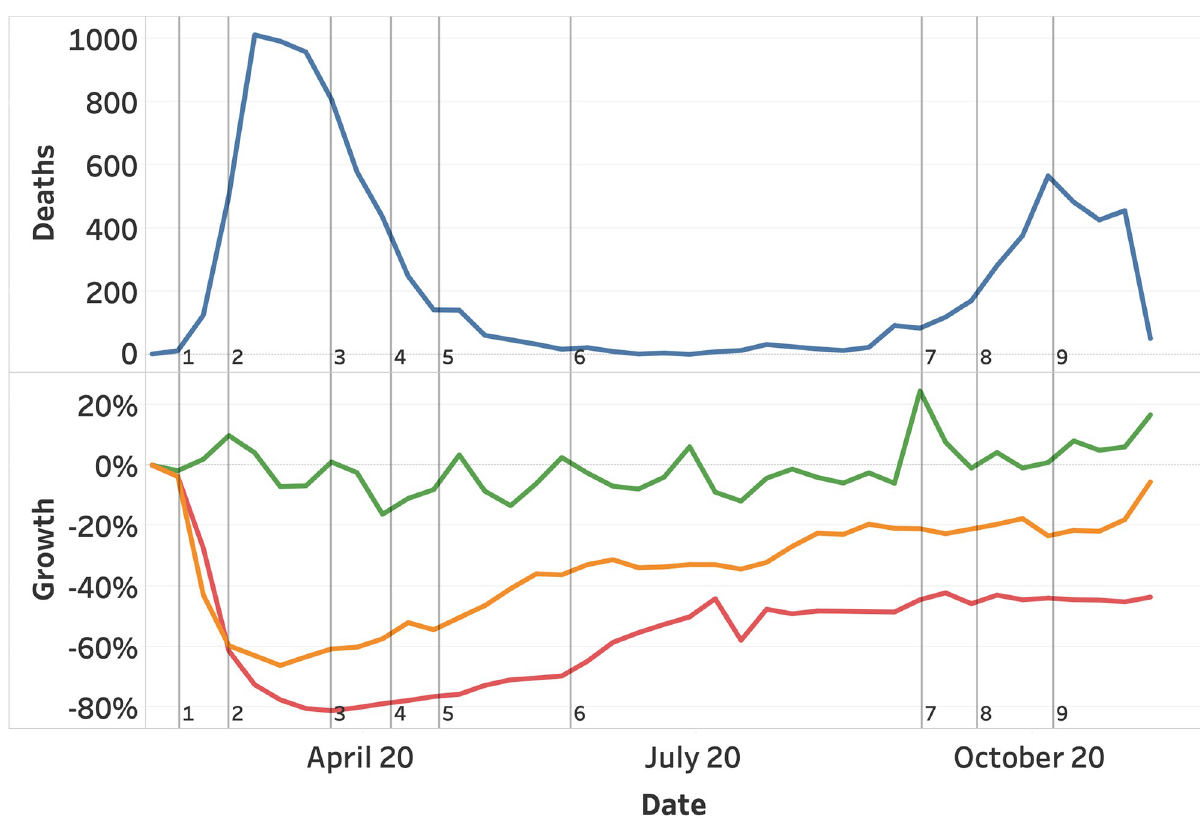
Fig 13. Corona deaths with growth in vessel, traffic, and flights with respect to the major changes in corona measures. Corona deaths (blue) and growth in vessel (green), traffic (orange), and flights (red). (1) closing all education, sport, and public areas. (2) reducing group sizes from 100 to 3 and closing close contact professions. (3) Opening sports under 18 years. (4) Opening close contact professions and sports for adults. (5) Open restaurants, increase group sizes from 3 to 6 and introduce mandatory face masks in public transport. (6) remove maximum visitors for restaurants and open gyms. (7) Reduce restaurant capacity to 30. (8) Close restaurants and max group sizes to 4. (9) Max group sizes to 2.